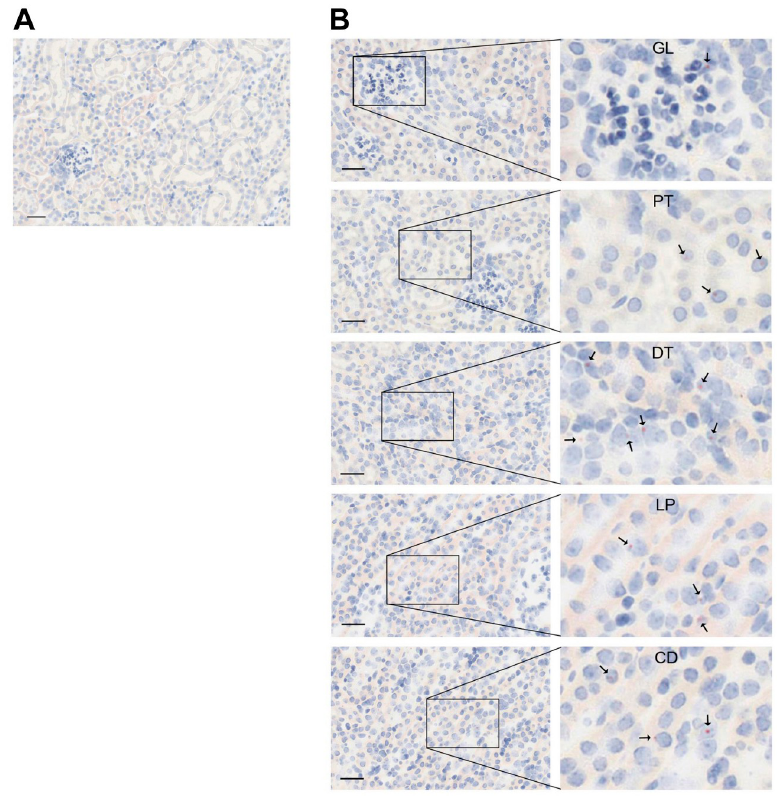
Fig 1. Vpr gene expression in nephrons of Vpr-Tg mice analyzed by BaseScope. ( A ) negative control image from the WT mouse kidney section which was hybridized using a Vpr probe. ( B ) The same Vpr probe was hybridized as ( A ) Vpr RNA (pink), indicated by arrows in images from Tg mouse kidney tissue sections. GL, glomerulus; PT, proximal tubule; LP, loop of Henle; DT, distal convoluted tubule; CD, collecting duct. Scale bar, 20 μ m.